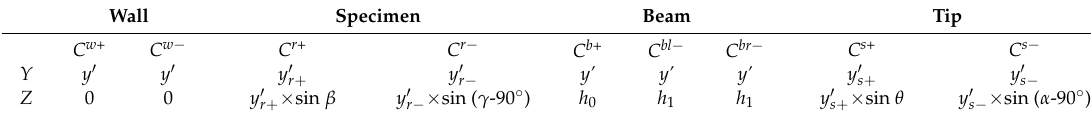
Table A1. The variables of observation point ( Y , Z ) at each integral